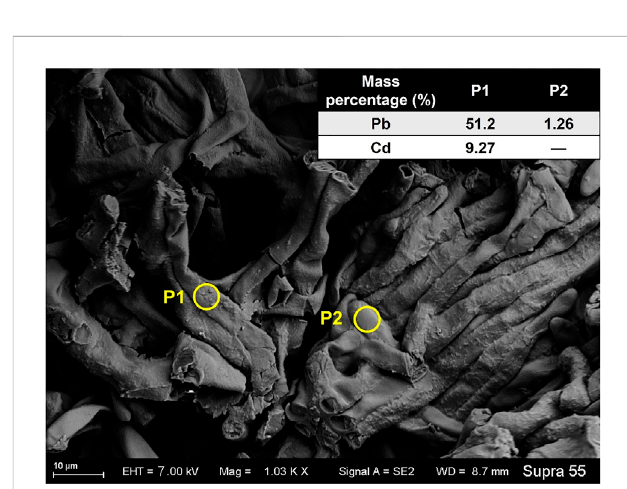
FIGURE 2 The SEM image of Aspergillus niger after 5 days incubation in the TPbCd treatment. The representative spots of P1 and P2 were selected for EDS